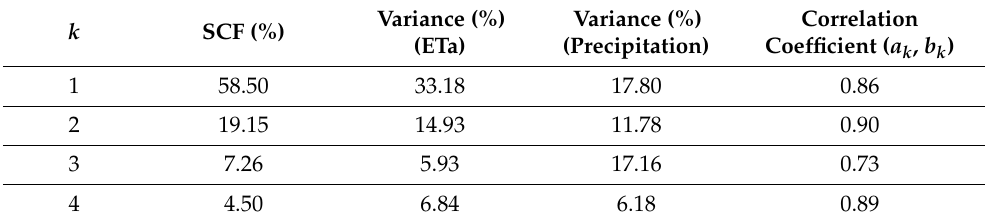
Table 2. SVD analysis between ETa and precipitation in northern China during 1982–2017. Squared covariance fraction (SCF) (%) is the fraction of the total squared covariance accounted for by the SVD